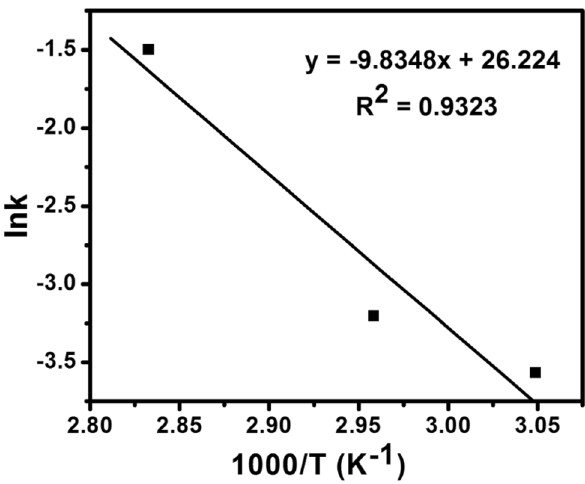
Figure 11. Plot of Ink against 1/T (second-order model) for esterification of OA over 6TsOH-MBC catalyst.